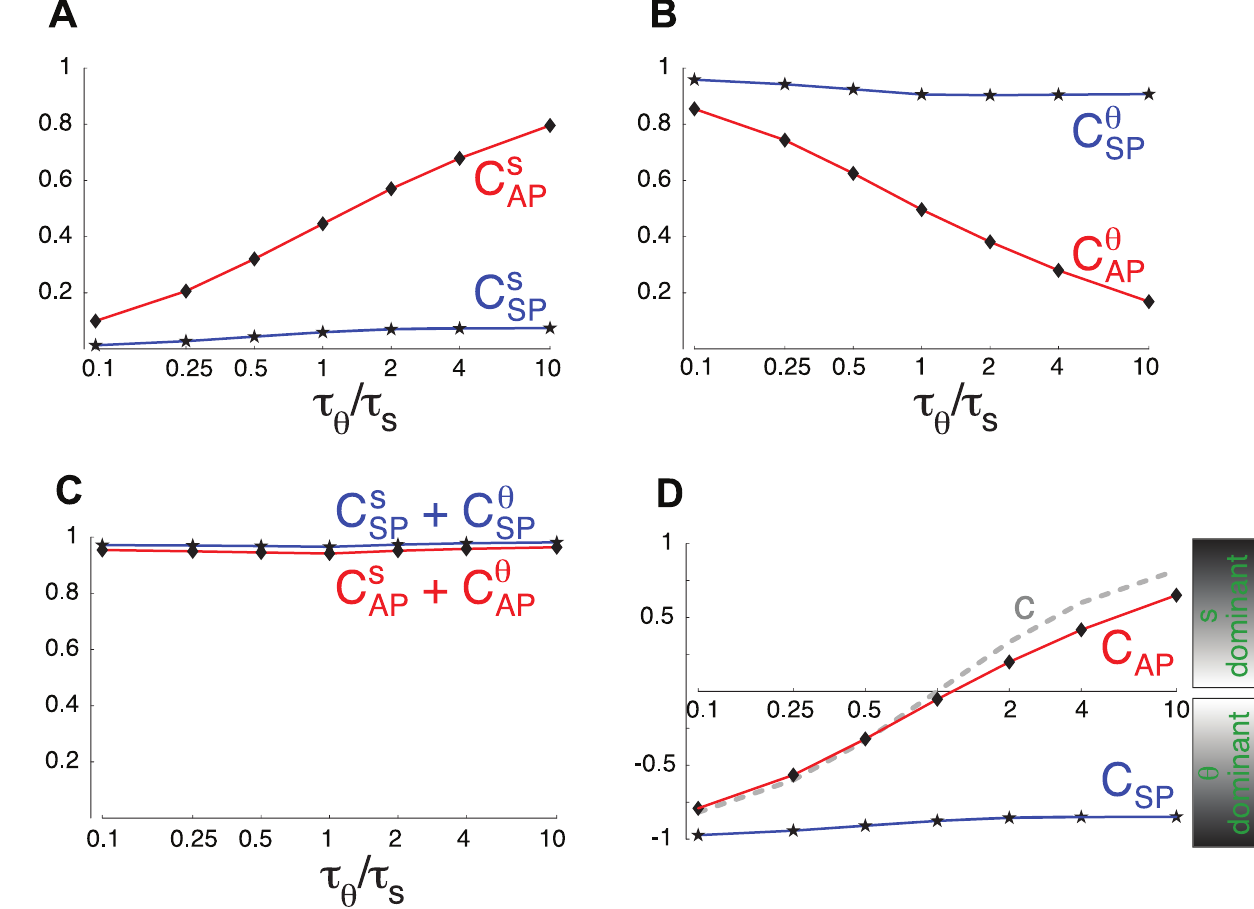
Figure 5. Variations of the contributions of s and h with t h / t s . A. Contributions of s to episode termination (C s AP , red, diamonds) and initiation (C s SP , blue, stars). B. Contributions of h to episode termination (C h AP , red, diamonds) and initiation (C h SP , blue, stars). C. Both sums C s AP + C h AP (red, diamonds) and C s SP + C h SP (blue, stars) are close to 1, demonstrating the consistency of the measures. D. Combined measures C AP (red, diamonds) and C SP (blue, stars), as defined in Eq 11–12, superimposed with the prediction from the correlative measure c (dashed curve, as in Figure 1C). C AP < 2 1: h controls the active phase; C AP < 0: both h and s have equal contributions to setting the duration of the active phase; C AP < 1: s controls the active phase (and similarly for C SP and the silent phase). Variations of C AP show that the relative contribution of s to the termination of the active phase increases with t h / t s , in agreement with the correlative approach. On the other hand, C SP remains close to -1, showing that the subtractive process ( h ) controls episode onset over the whole